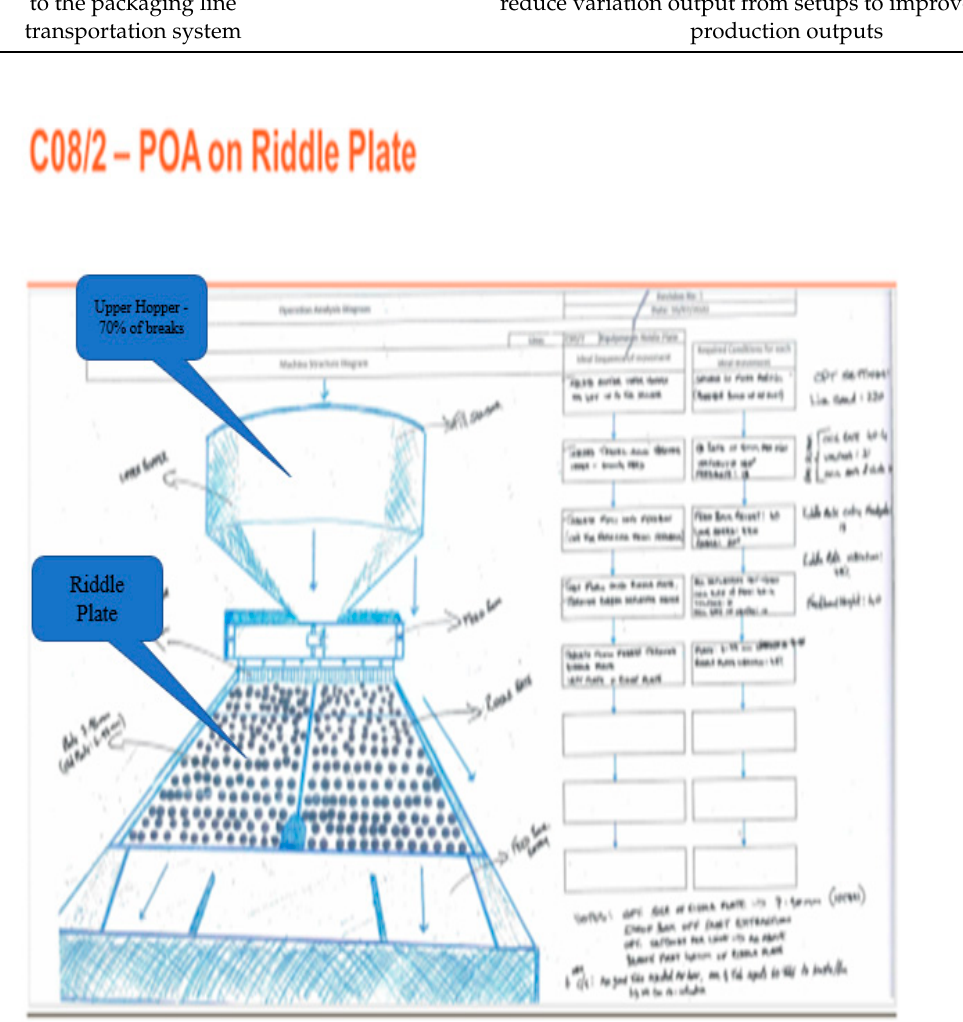
Figure 19. POA and pilot on a tailor-made product-specific riddle plate to understand how the plate would work. A new riddle plate was trialed on the C08/2 line whilst running 10C821 tablet type.